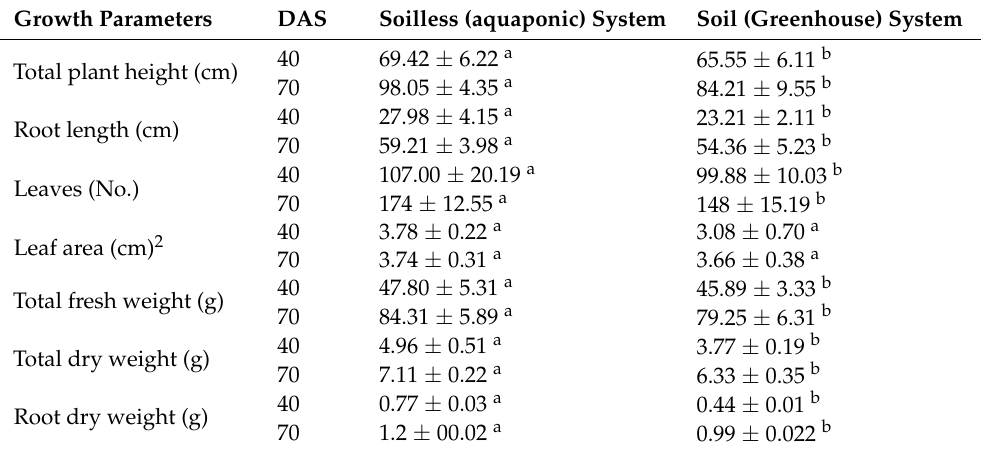
Total dry weight (g) Root dry weight